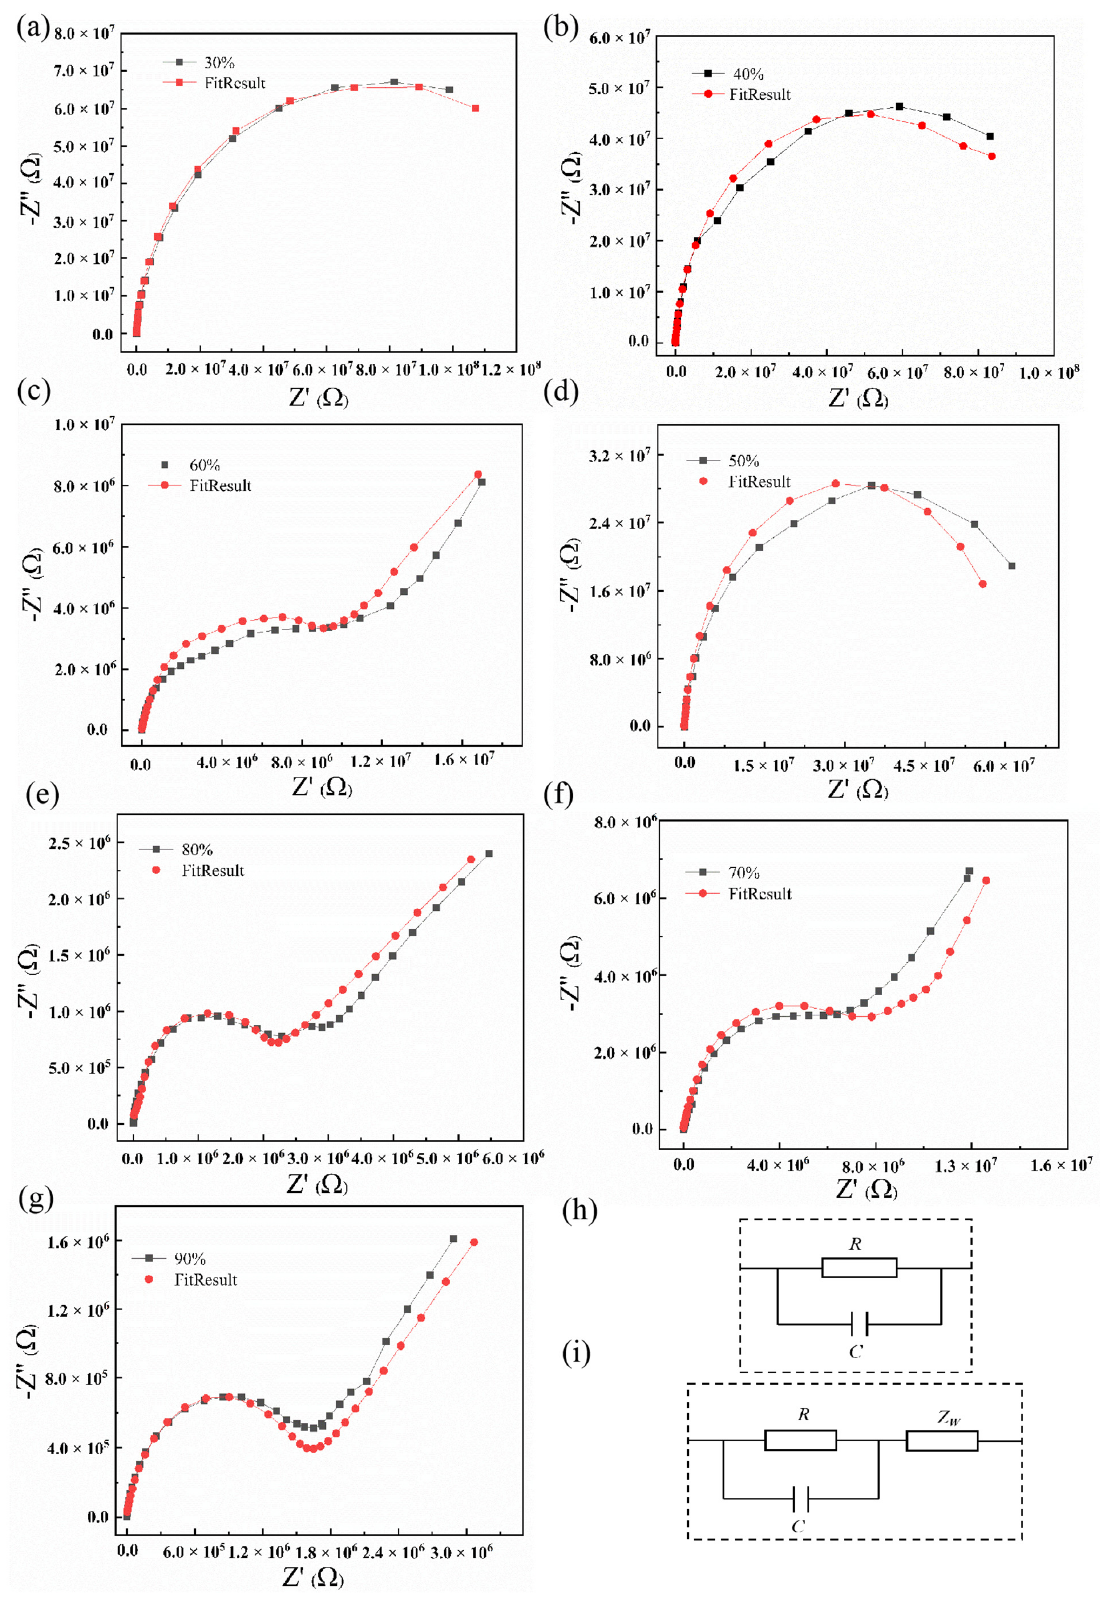
Figure 7. The complex impedance properties of BiFeO 3 film under different humidities. ( a ) 30% RH; ( b ) 40% RH; ( c ) 50% RH; ( d ) 60% RH; ( e ) 70% RH; ( f ) 80% RH; ( g ) 90% RH. ( h ) The equivalent circuit fit by Zview in the 30 − 50% RH range. ( i ) The equivalent circuit fit by Zview in the 60 − 90% RH